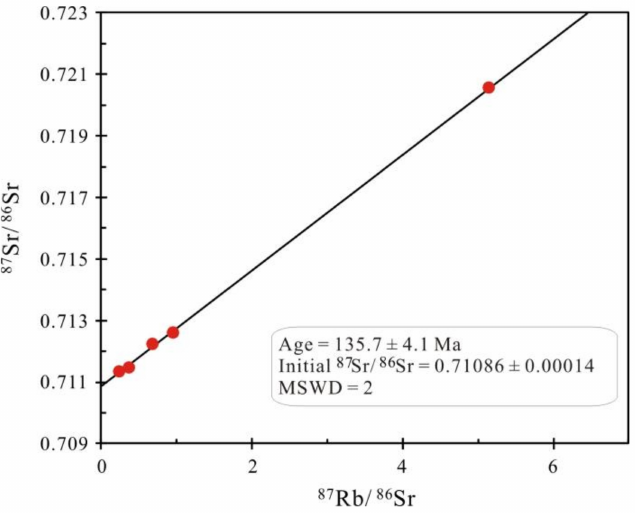
Figure 6. Rb-Sr isochron diagram of sulfides from the Yingfang deposit.